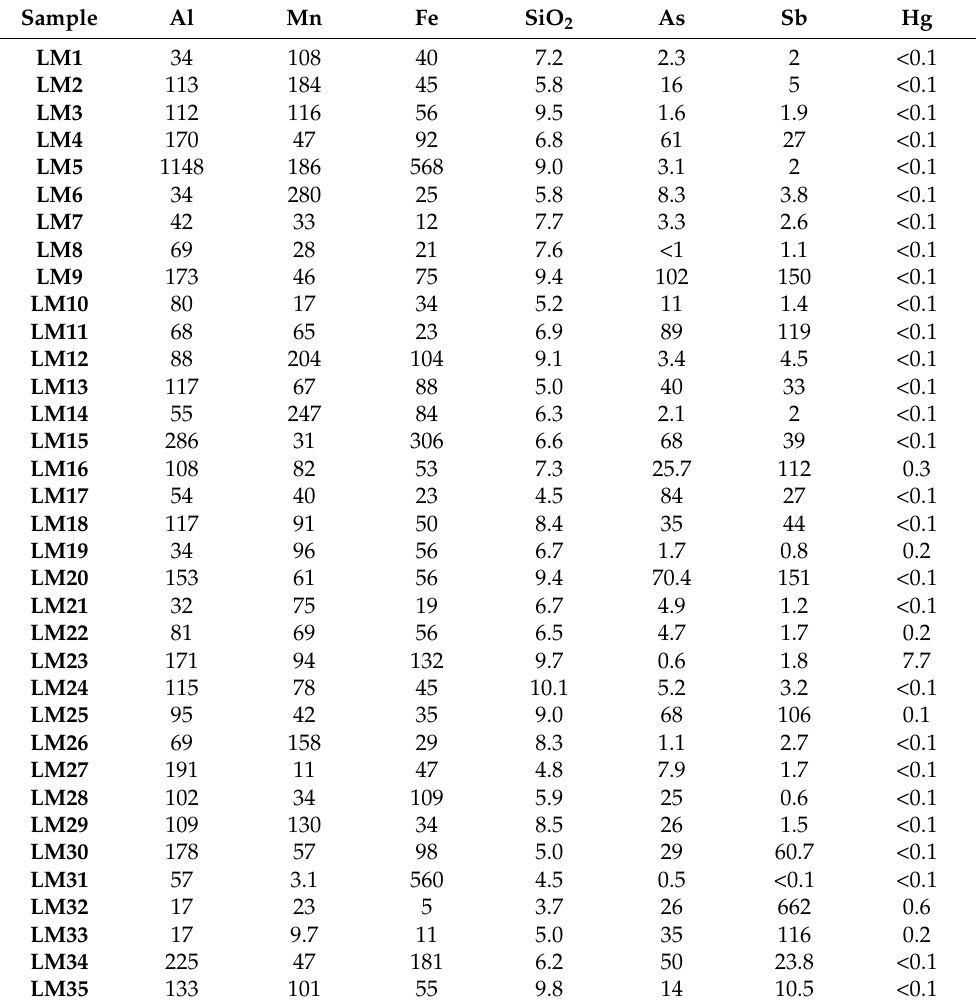
Table 6. Concentrations of metals and metalloids ( µ g · L − 1 ) and SiO 2 (mg · L − 1 ) in the CO 2 -saturated MilliQ